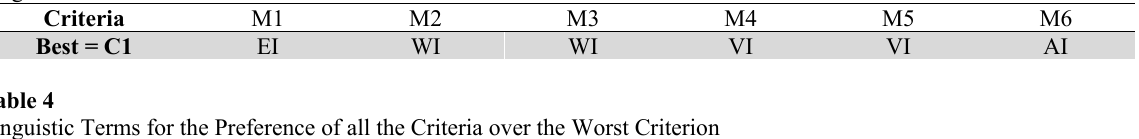
Linguistic Terms for the Preference of all the Criteria over the Worst Criterion